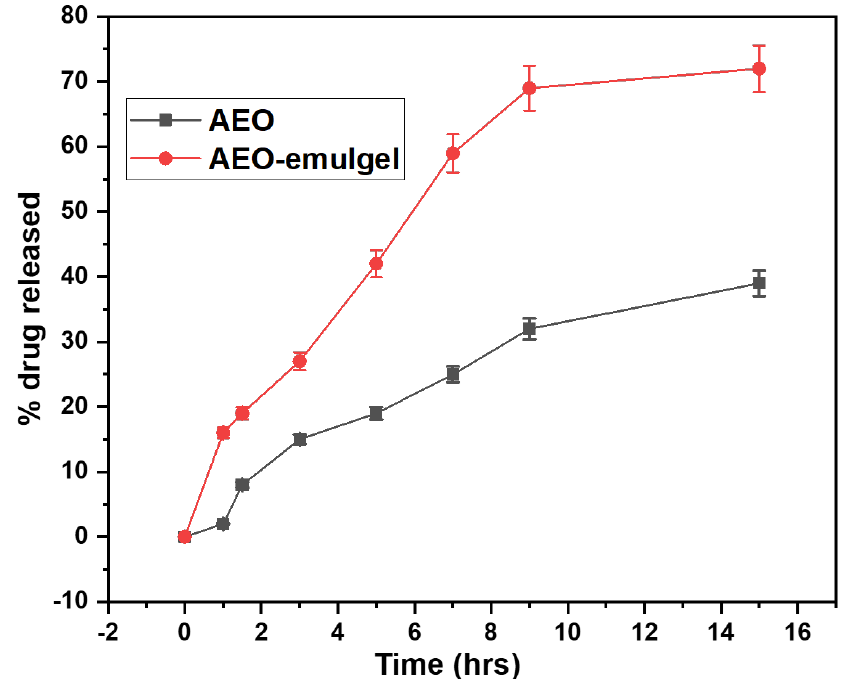
Figure 5. Comparative in-vitro drug released study of AEO and AEO-emulgel at pH 6 for 15